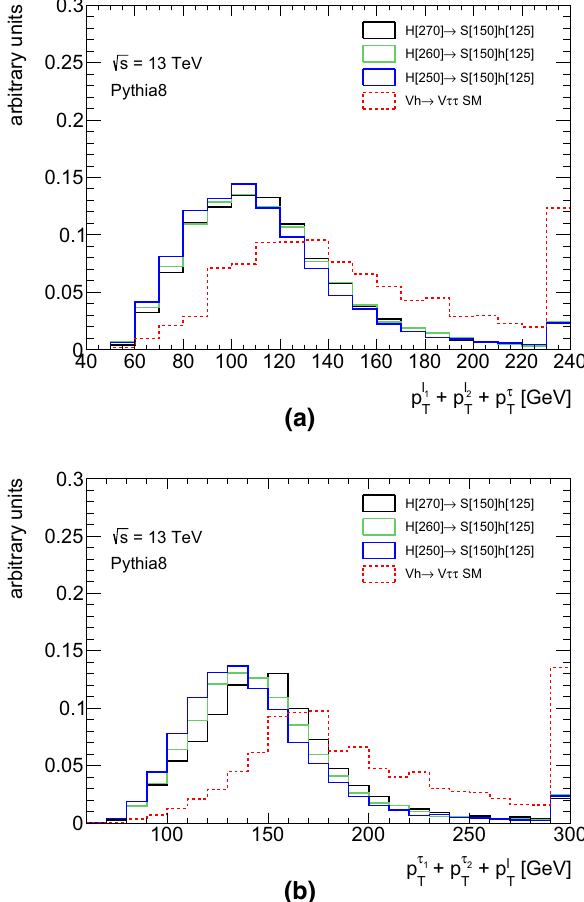
Fig. 3 Scalar sum of the transverse momentum of two leptons and a hadronic tau ( a ) and scalar sum of the of transverse momentum of the lepton and two hadronic taus ( b ) for several H → Sh samples (solid lines) compared with the SM Vh process with h → ττ (dashed line) generated with PYTHIA8 . The last bin contains overflow